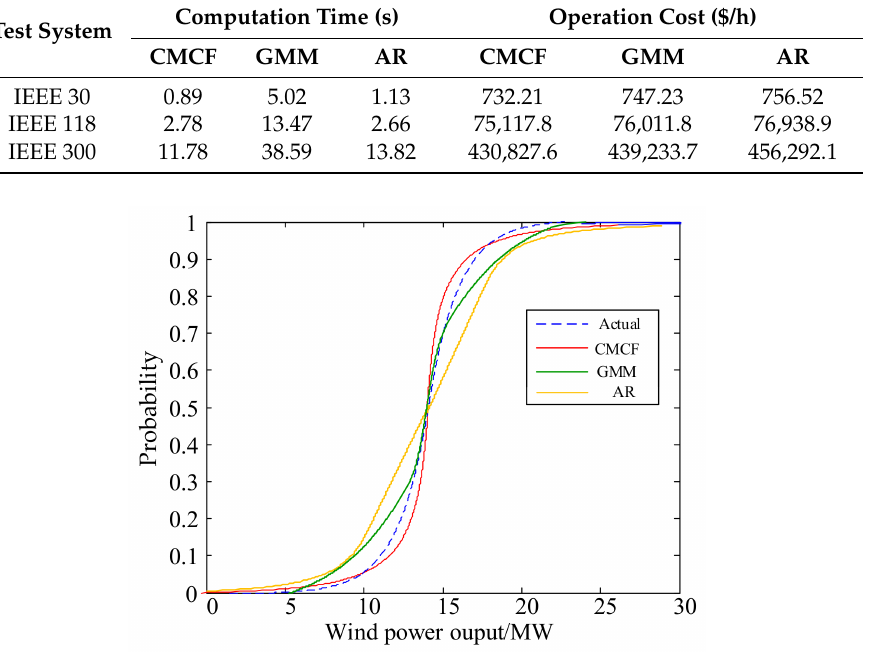
Figure 8. Wind power output distribution of wind farm